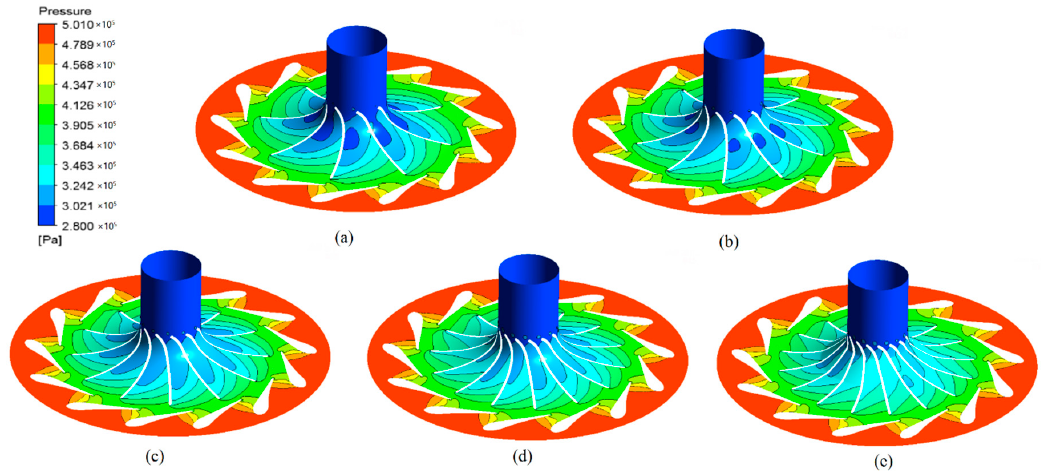
Figure 10. Pressure distribution at mid-span of air: ( a ) solidity 7.96; ( b ) solidity 9.95; ( c ) solidity 11.94; ( d ) solidity 13.93; ( e ) solidity ( d ) solidity 13.93; ( e ) solidity 15.92.